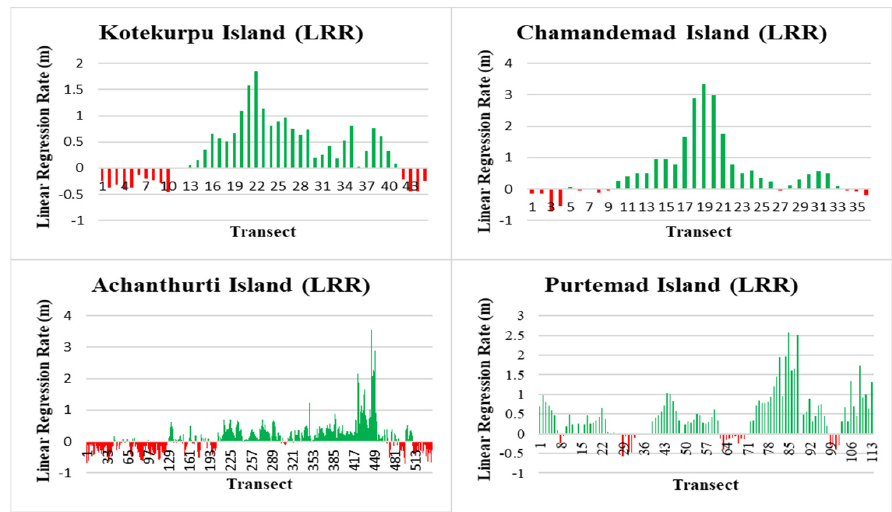
Figure 6. Bar graphs representing linear regression rate of Kavvayi island, Madkel island, Yedalekad island, Tekkekad island, and Badkekad islands of Kotekurupu island, Chamandemad island, Achanthurti island, and Purtemad island of Kavvayi wetland.